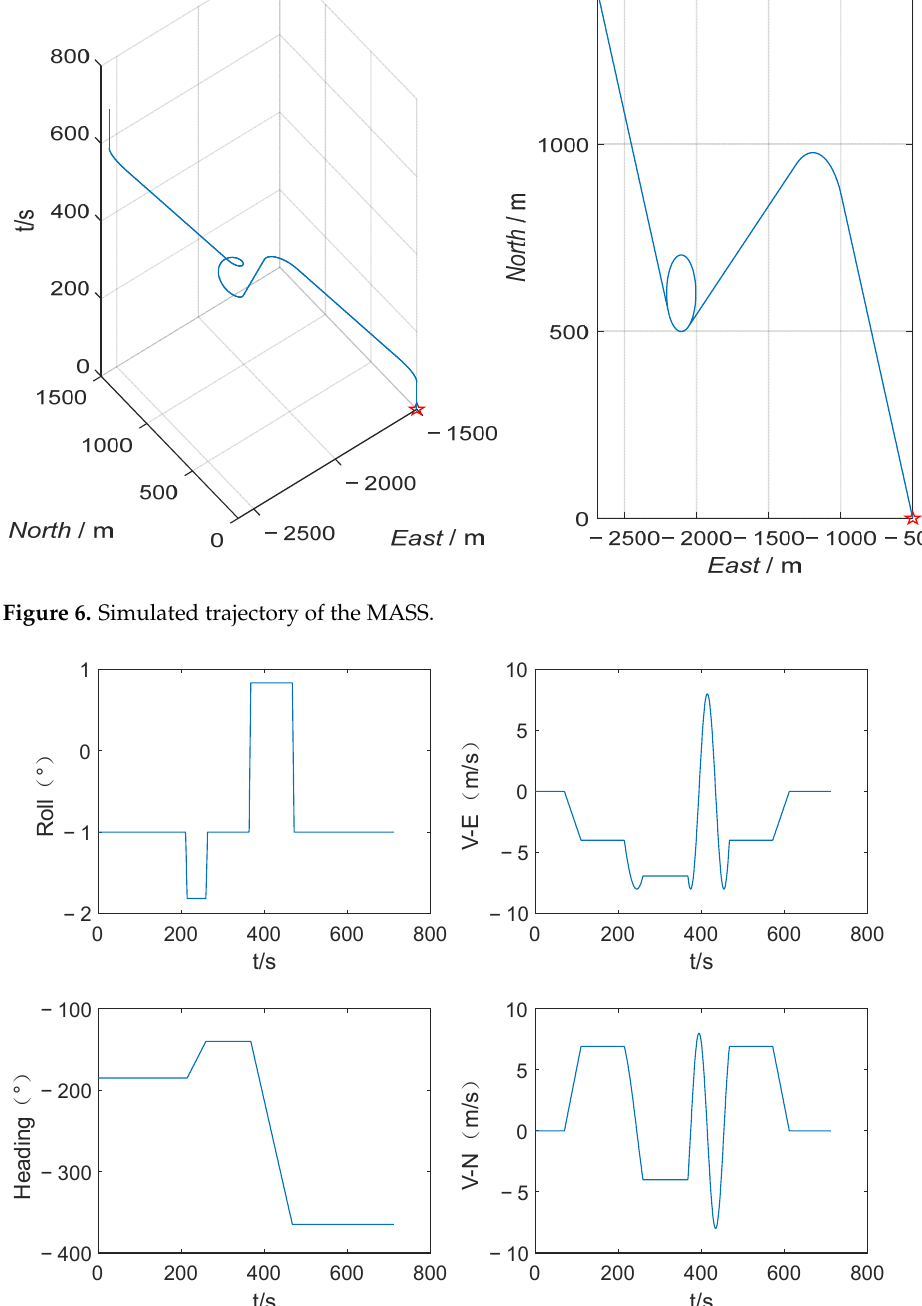
Figure 8. Error velocity of CKF filter under different delay conditions.